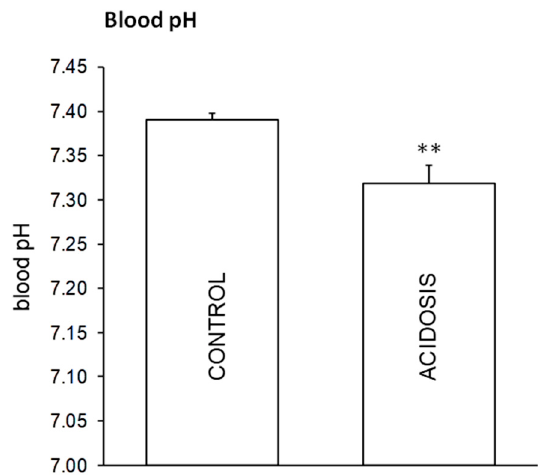
Figure 1. Blood pH values after the induction of metabolic acidosis by administration of 0.28 M NH 4 Cl in drinking water for 7 d. Values are means ± S.E. ** p ≤ 0.05 vs control. Number of experiments = 16.